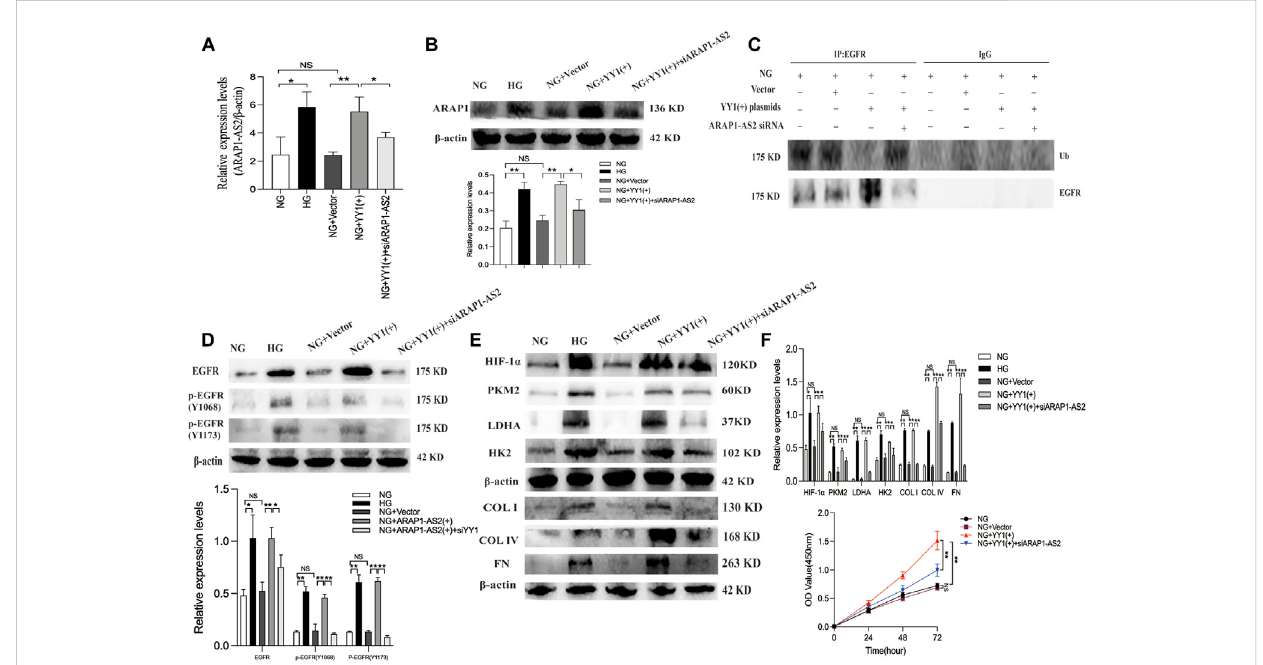
FIGURE 9 YY1 regulate EGFR ubiquitination and activation, HIF-1 α accumulation and aberrant glycolysis and ECM accumulation in human glomerular mesangial cells through the ARAP1-AS2/ARAP1 axis. (A) Forty-eight hours after co-transfection of the YY1 overexpression plasmid and ARAP1-AS2 siRNA in the NG group, the expression level of ARAP1-AS2 was examined by qRT-PCR. (B) Forty-eight hours after co-transfection of the YY1 overexpression plasmid and ARAP1-AS2 siRNA in the NG group, the protein expression levels of ARAP1 were examined by Western blot analysis. (C) Forty-eight hours after co-transfection of the YY1 overexpression plasmid and ARAP1-AS2 siRNA in the NG group, EGFR ubiquitination were examined. (D) Forty- eight hours after co-transfection of the YY1 overexpression plasmid and ARAP1-AS2 siRNA in the NG group, the protein expression levels of total EGFR, and EGFR phosphorylated at two phosphorylation sites (Y1068 and Y1173) were examined by Western blot analysis. (E) Forty-eight hours after co- transfection of the YY1 overexpression plasmid and ARAP1-AS2 siRNA in the NG group, the protein expression levels of HIF-1 α , PKM2, LDHA, HK2, COL I, COL IV and FN were examined by Western blot analysis. (F) After co-transfection of the YY1 overexpression plasmid and ARAP1-AS2 siRNA, cell proliferation was evaluatedbyCCK-8assayat0,24, 48and72 h.Inallpanels,thedata arerepresentativeofatleastthreeindependentexperiments.Data are presented as the mean ± SD. * p < 0.05, ** p < 0.01, NS, not signi fi